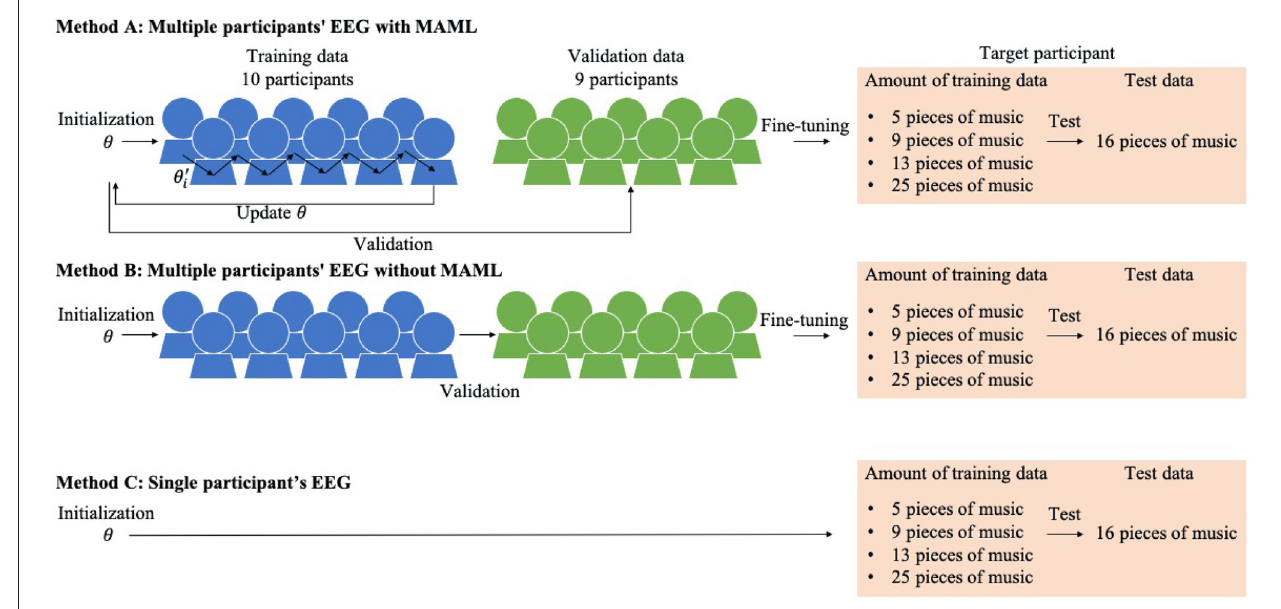
FIGURE 2 | Three emotion prediction methods using a single target participant’s small amount of EEG